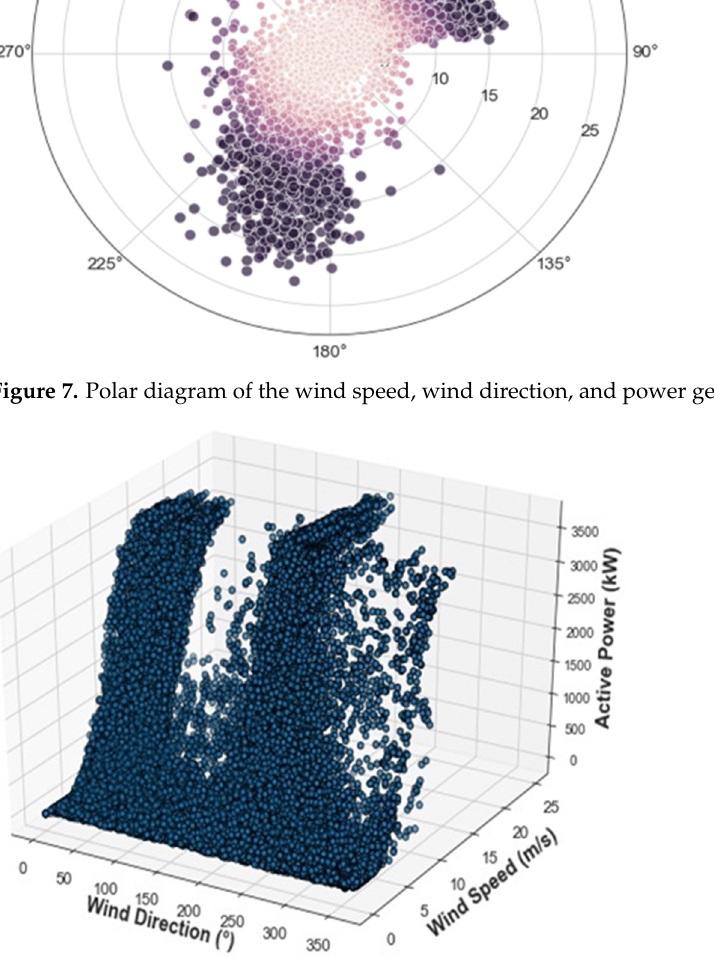
Figure 7. Polar diagram of the wind speed, wind direction, and power generation.